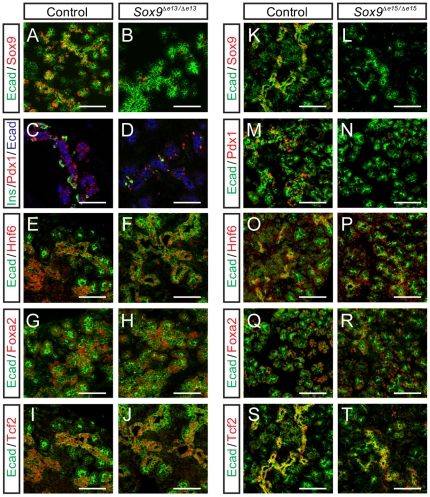

Sox9 deletion during endocrine cell neogenesis results in reduced numbers of Pdx1+ cells.Immunofluorescence staining of control (A, C, E, G, I, K, M, O, Q, S) and R26-CreER; Sox9flox/fox embryos (B, D, F, H, J, L, N, P, E, T) injected with tamoxifen at e12.5 and analyzed at e15.5 (Sox9Δe13/Δe13) or injected with tamoxifen at e14.5 and analyzed at e18.5 (Sox9Δe15/Δe15). Sox9 expression is lost in the majority of E-cadherin+ (Ecad+) epithelial cells (B, L). Deletion of Sox9 results in decreased expression of Pdx1 (D, N) as well as a reduction in the number of insulin+ (Ins+) cells, while Hnf6 (F, P), FoxA2 (H, R), and Tcf2 (J, T) expression is unaffected. Scale bar: 50 µm.